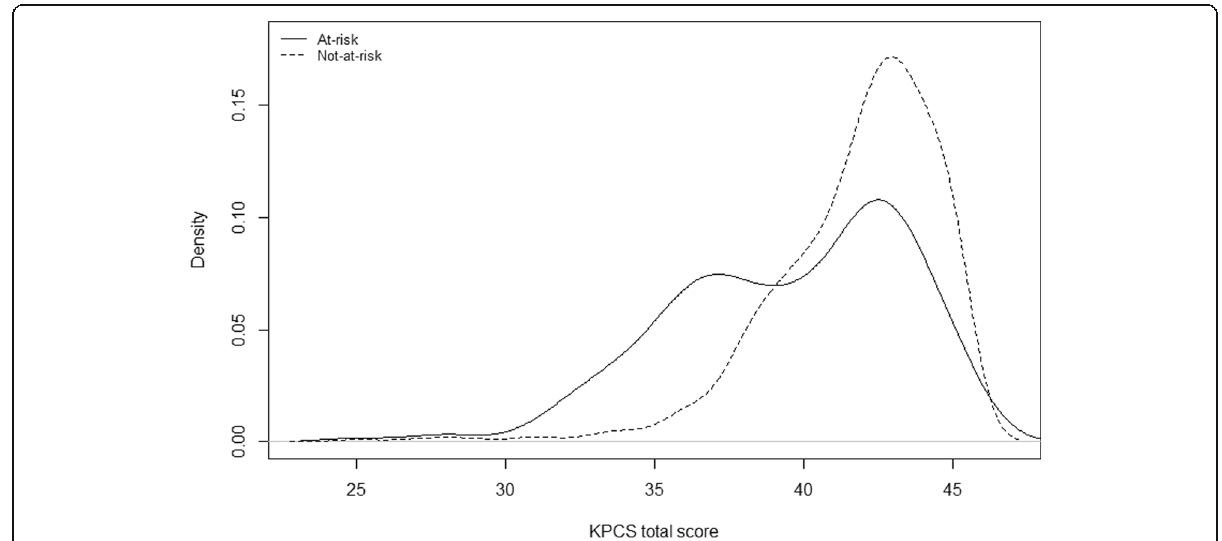
Fig. 1 Density plot of KPCS mean scores for at-risk and not-at-risk mothers at two months